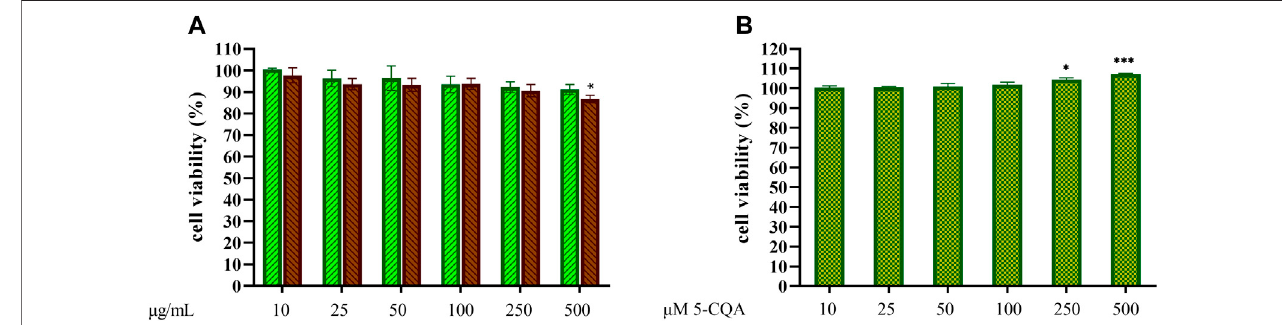
FIGURE 2 | THP-1-derived macrophages viability. THP-1-derived macrophages (TDM) cell viability after treatment with increasing concentrations of GCE (A , green, down-up diagonal pattern ) and RCE (A , brown, up-down diagonal pattern ) and 5-CQA (B , square pattern ) was evaluated by MTT assay (24 h). Data are represented as mean ± SEM of three independent experiments ( n = 3). Results refer to untreated control (100%) (one-way ANOVA, * p < 0.05, ** p < 0.01, *** p < 0.001, **** p < 0.0001).